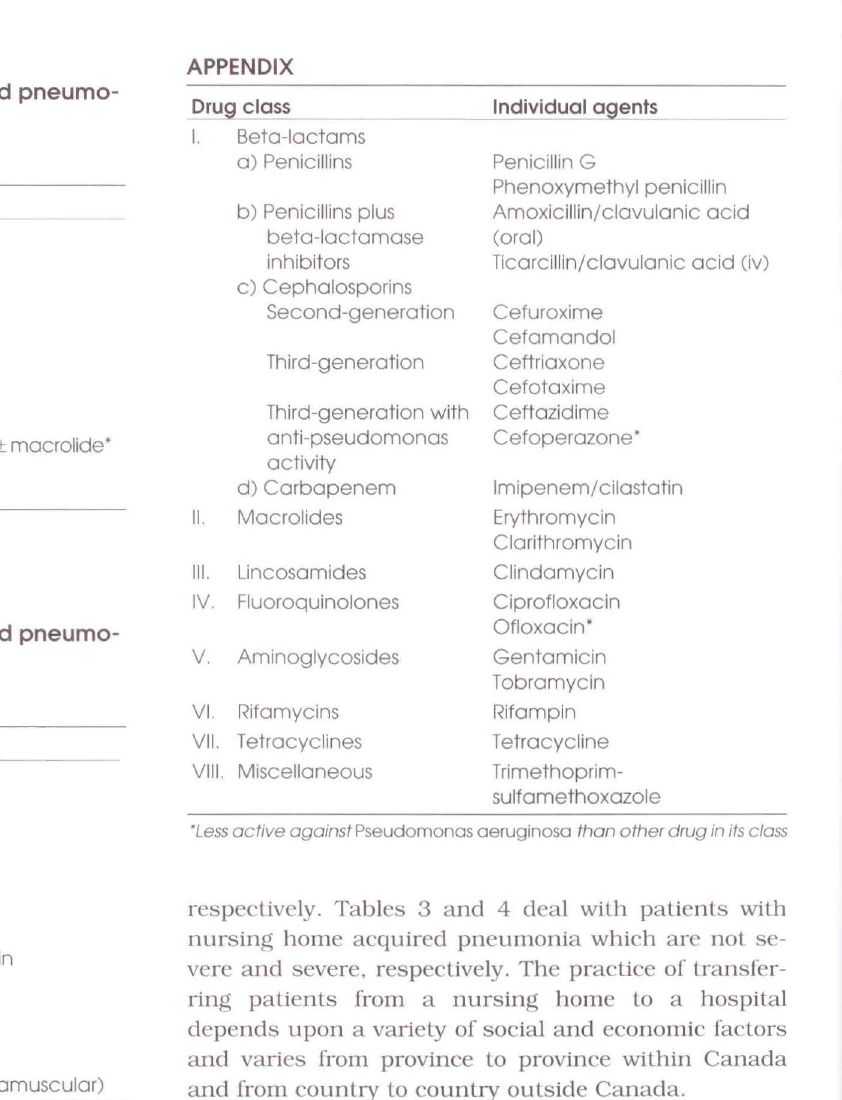
Treatment options for nursing home acquired pneumo nia Clinical presentation - severe Treatment - in nursing